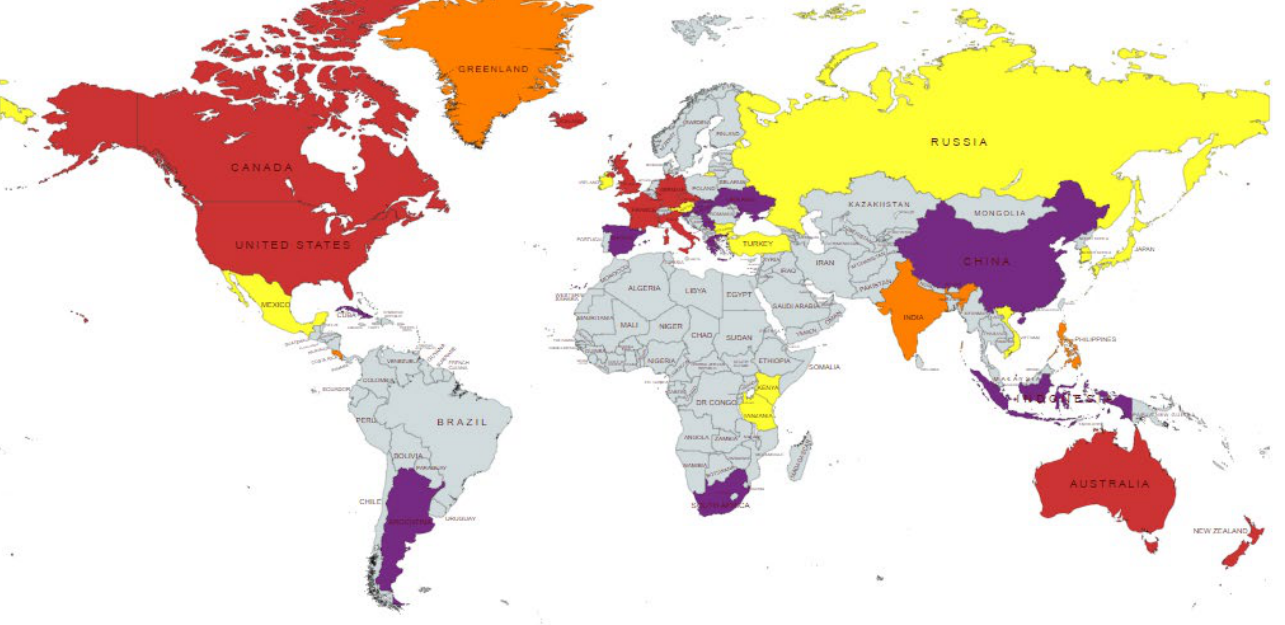
Figure 1. Most common identified locations of zeolites and specific occurrences of erionite and offretite (without distinction between habits). Key: purple = zeolites (general); yellow = erionite (only); orange = offretite (only); red = erionite and offretite. References: Zeolite Mining–[31–33]. Erionite deposits–[34–44] and mentioned in [45]. Offretite deposits–[36,46].